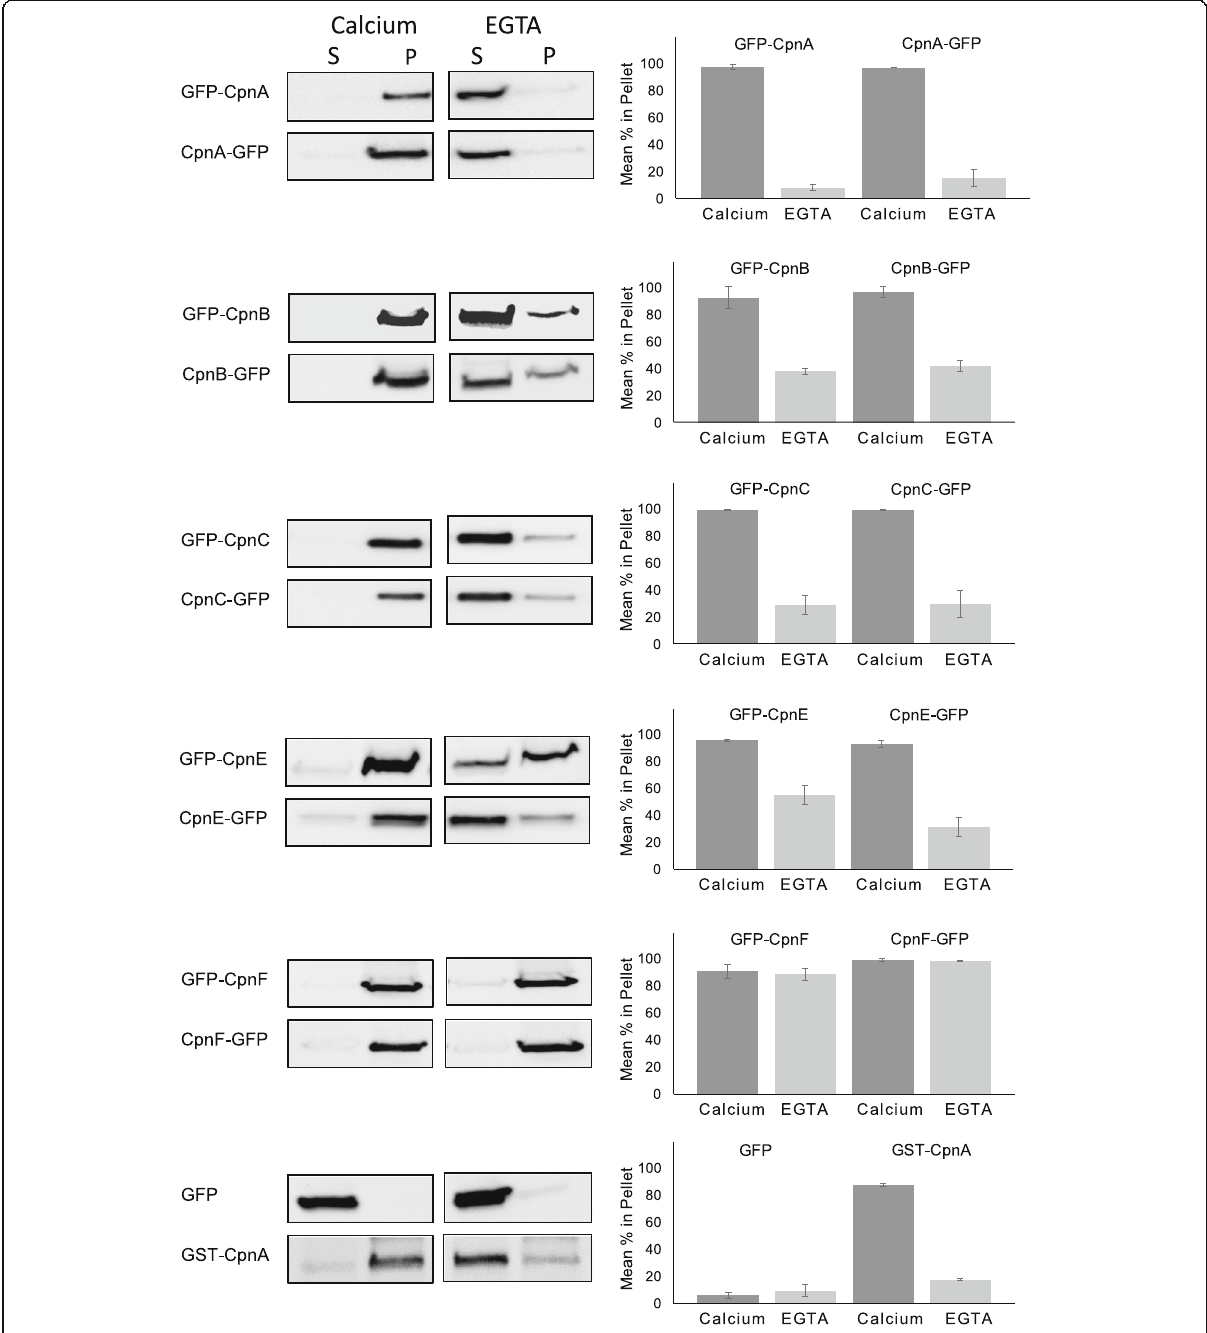
Fig. 5 Copines have different calcium-dependent and -independent membrane-binding properties. Cells expressing GFP, a GFP-tagged copine, or GST-CpnA were disrupted and all membranes were pelleted by ultracentrifugation in the presence (calcium) or absence of calcium (EGTA). The supernatant samples (S) and pelleted membranes samples (P) were analyzed by Western blot with an antibody to GFP. Three blots were analyzed by densitometry and the average percentage of the protein found in the pellet was graphed. Error bars = standard